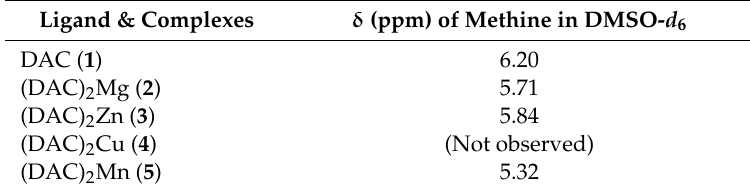
Table 3. 1 H-NMR chemical shifts of the methine proton of DAC and their metal